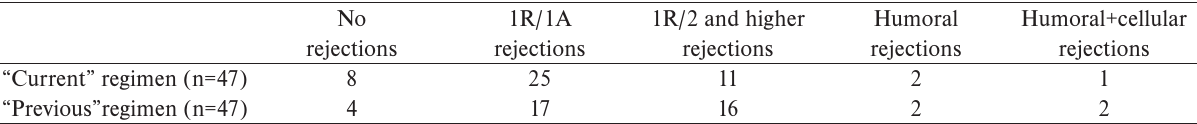
Table 4. Distribution of rejections in both